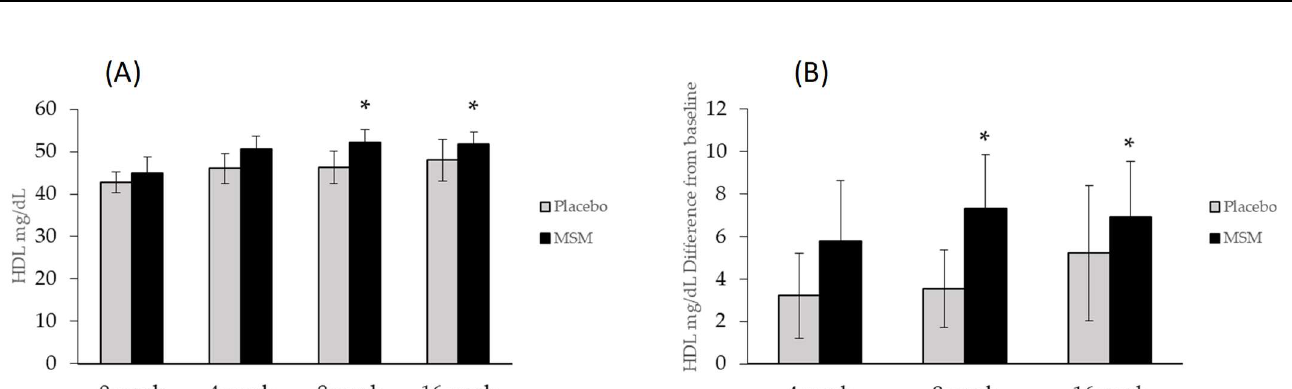
Figure 3. High-density lipoprotein cholesterol (HDL) was elevated at 8 and 16 weeks in the MSM group. ( A ) absolute values of HDL, ( B ) Differences from baseline. * Indicates different from baseline, p ≤ 0.05.